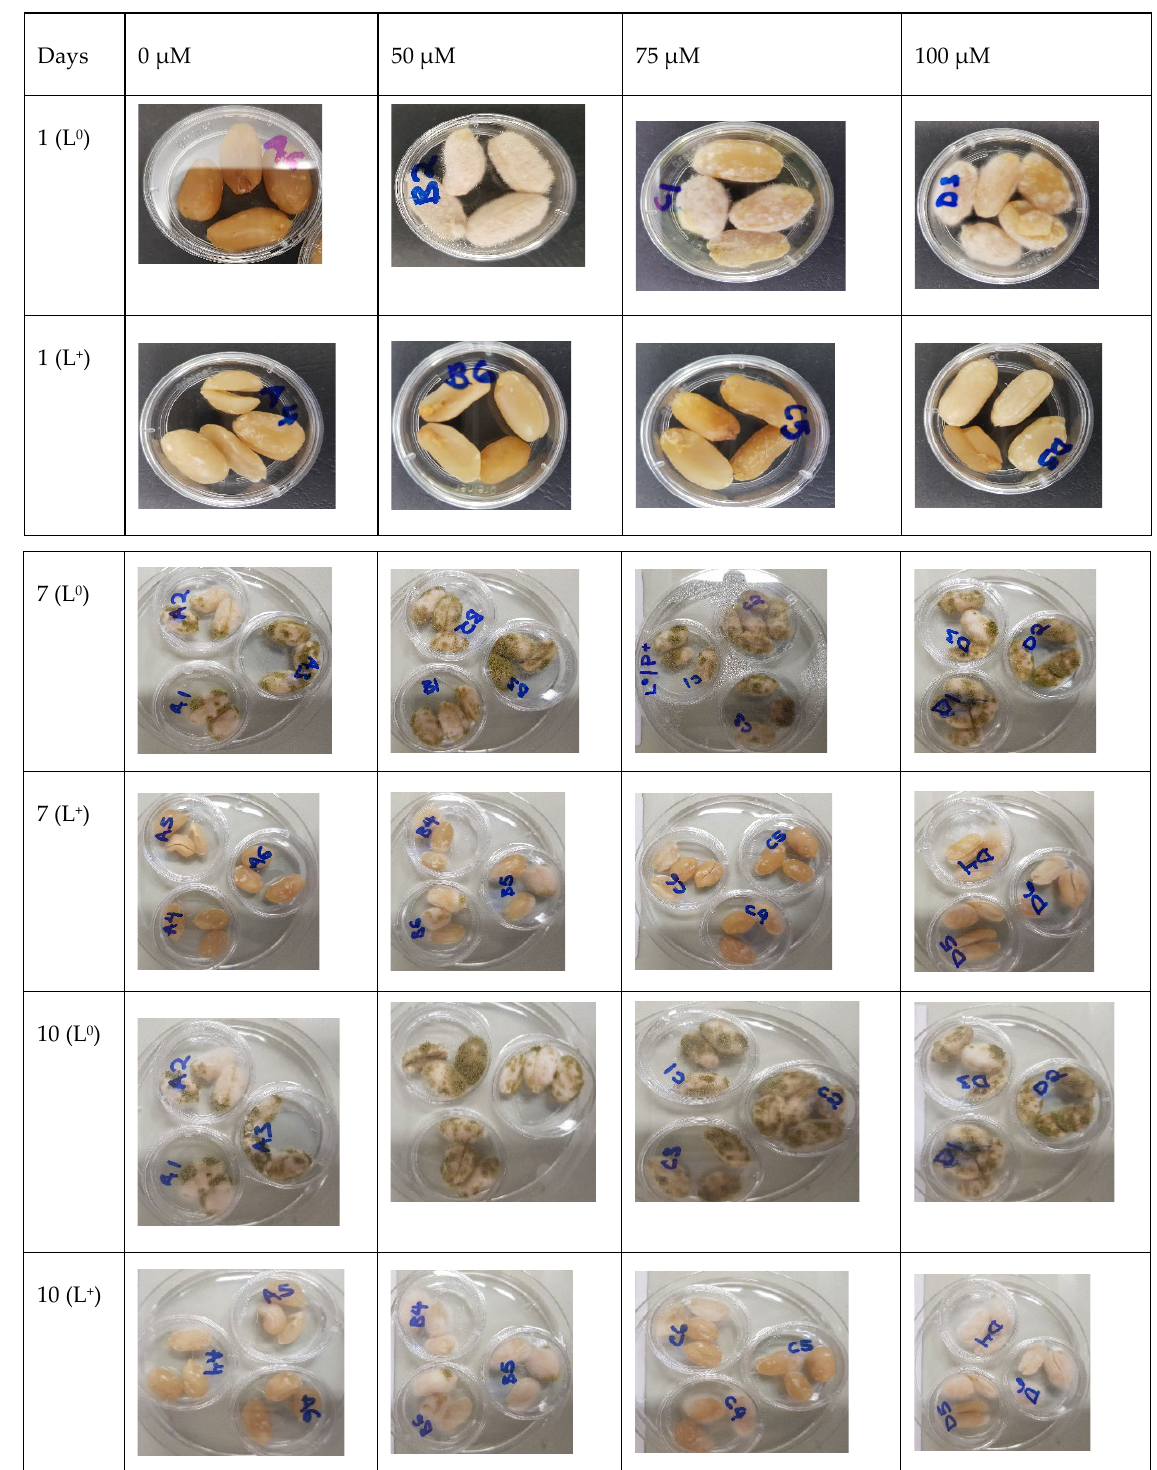
Figure 3. Growth of Aspergillus flavus on control and photosensitized peanuts stored at 25 ◦ C for 10 days after the treatment with 114.5 J/cm 2 of light combined with curcumin (50, 75, 100 µ M). The curcumin-based treatment (P + /L + ) was demonstrated to be effective in extending the shelf-life of the inoculated peanut kernels for 7 days at 25 ◦ C, in comparison with the control (P 0 /L 0 ), light-only (P 0 /L + ), and curcumin-only (P + /L 0 ) treatments. The